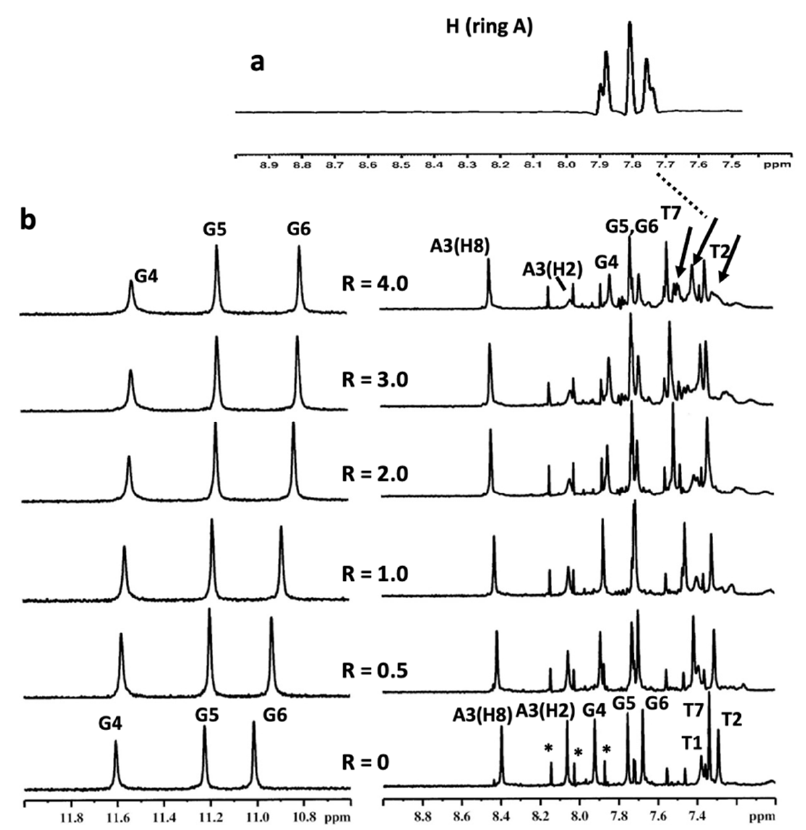
Figure 5. ( a ) Selected region of 1 H NMR spectrum of compound 9 at 25 ◦ C in H 2 O/D 2 O (9:1), 150 mM KCl, 25 mM K + phosphate buffer and EDTA 1 mM (pH 6.7); ( b ) imino and aromatic proton region of the 1 H NMR titration spectra of d(TTAGGGT) 4 with compound 9 at 25 ◦ C in H 2 O/D 2 O (9:1), 150 mM KCl, 25 mM K + phosphate buffer and EDTA 1 mM (pH 6.7), at different ratios R = [9]/[DNA]. The arrows indicate the broad proton signals of compound 9 . The peaks labelled with * correspond to the single-strand oligonucleotide.